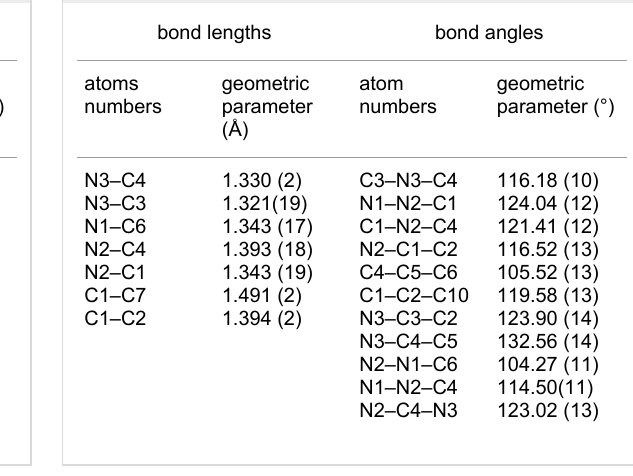
Table 3: Selected bond lengths and bond angles for compound 6e .